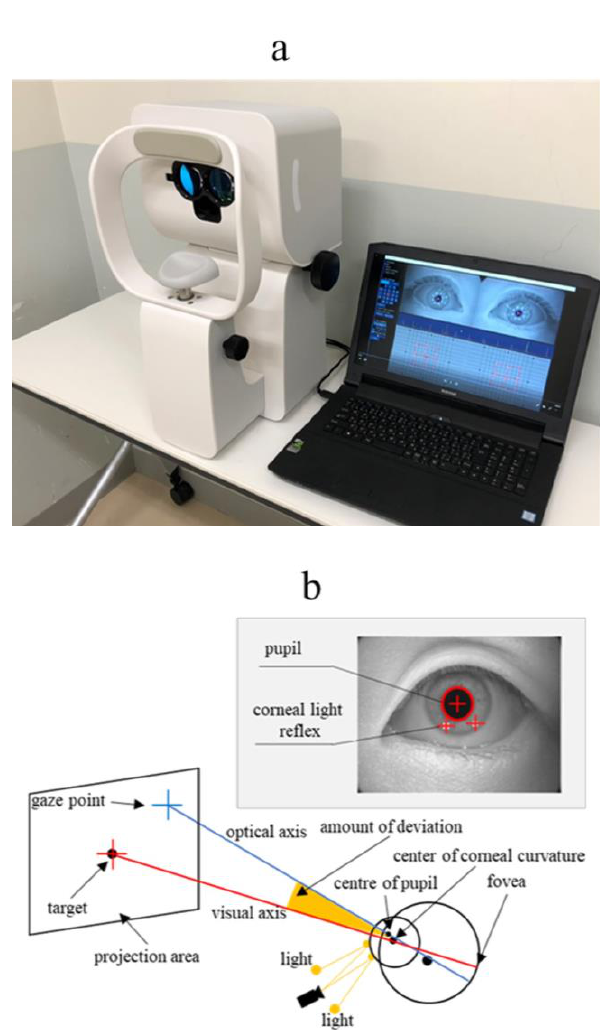
Figure 1 a: External view of the OMD; b: Overview of the prin- ciples of the OMD Examination 1: Examination of correlation, addi- tion error, and proportional error of the Hess screen test and the OMD. The subjects of the study were 20 healthy young people (mean age 20.9 ± 0.8 years) with ex- odeviation demonstrated with a subjective Hess screen test (test distance: 1.4 m, dichoptic image separation: red– green separation), and without any ophthalmological dis- eases other than refractive error. Each of the nine gaze-di- rections were measured using a Hess screen test and with the OMD, and correlation, addition error, and proportional error were examined. The right eye was used for measure- ment. The measurement order was